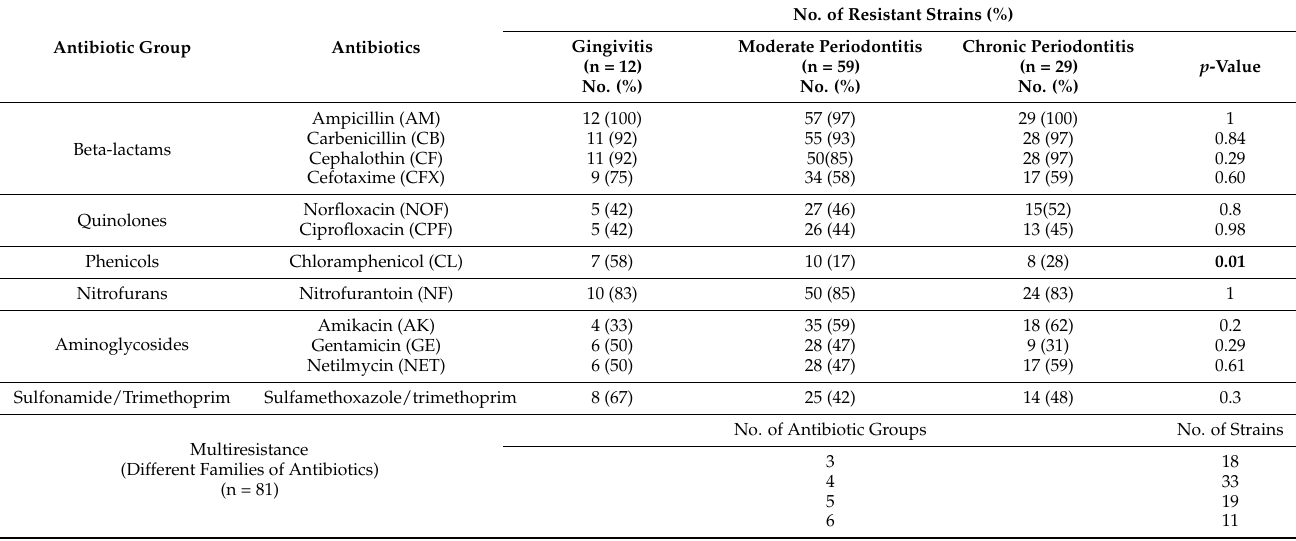
Table 1. Resistance and multiresistance to antibiotics in E. coli (n =